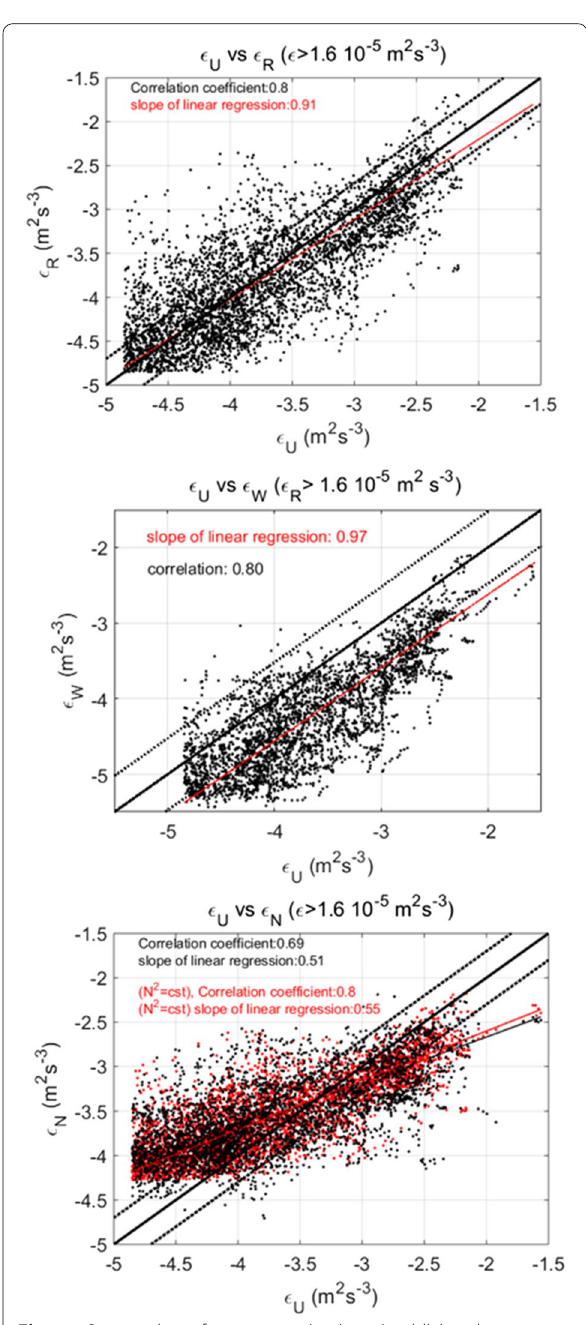
Fig. 15 Scatter plots of ε U versus ε R (top), ε W (middle) and ε N (bottom) after rejecting values smaller than 1.6 × 10 − 5 m 2 s − 3 . The bottom panel shows the results with measured N 2 and with N 2 = 1.47 × 10 − 4 s −